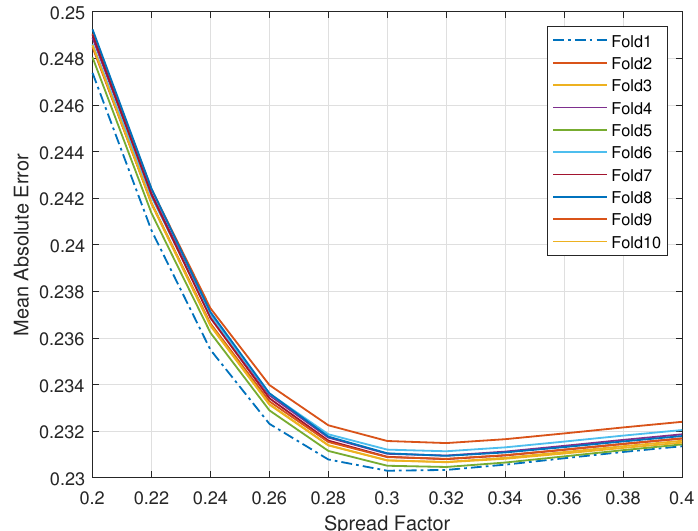
Figure 5. Measured MAE versus spread factor values for 10